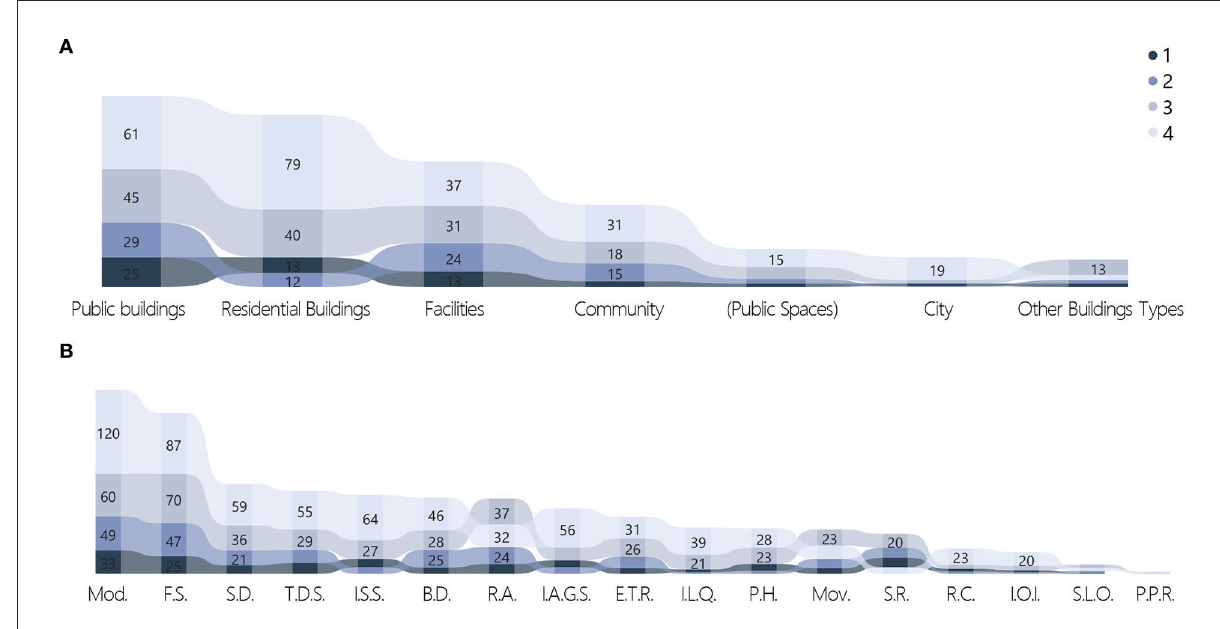
FIGURE14 Cross-tabulation results with award level. (A) Award level and architecture category. (B) Award level and